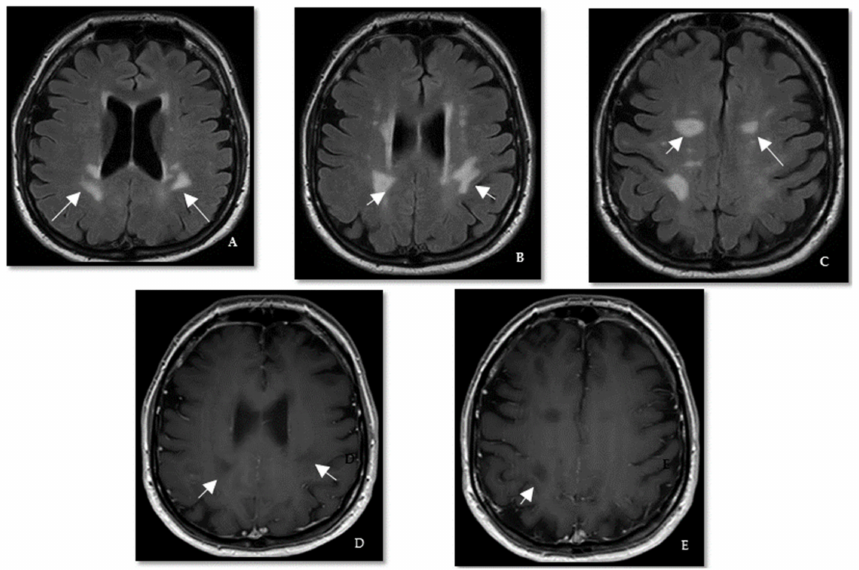
Figure 3. Case III. ( A – C ) Axial T2/FLAIR brain MRI shows periventricular hyperintense le- sions (white arrows). ( D , E ) Axial T1-Gad brain MRI shows non-contrast enhancing black holes (white